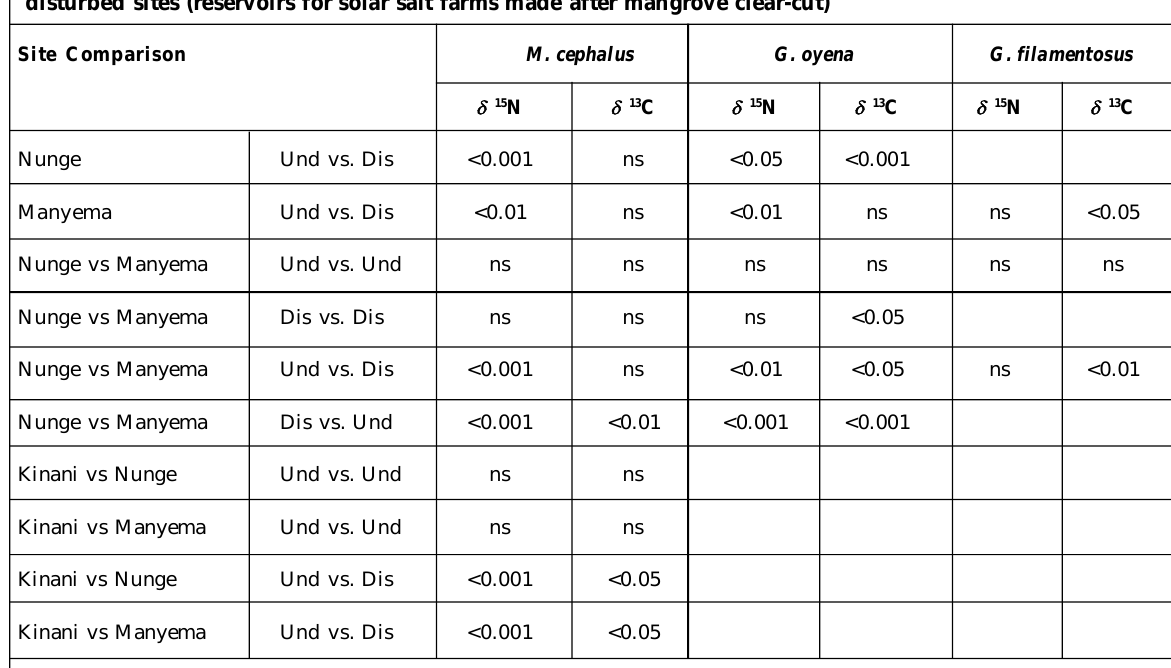
Table 5: Results of Post hoc comparison tests of  15 N and  13 C values of muscle tissues of different fish species caught from various sites in mangrove creeks. Und = undisturbed (no mangrove clearing) and Dis = disturbed sites (reservoirs for solar salt farms made after mangrove clear-cut)